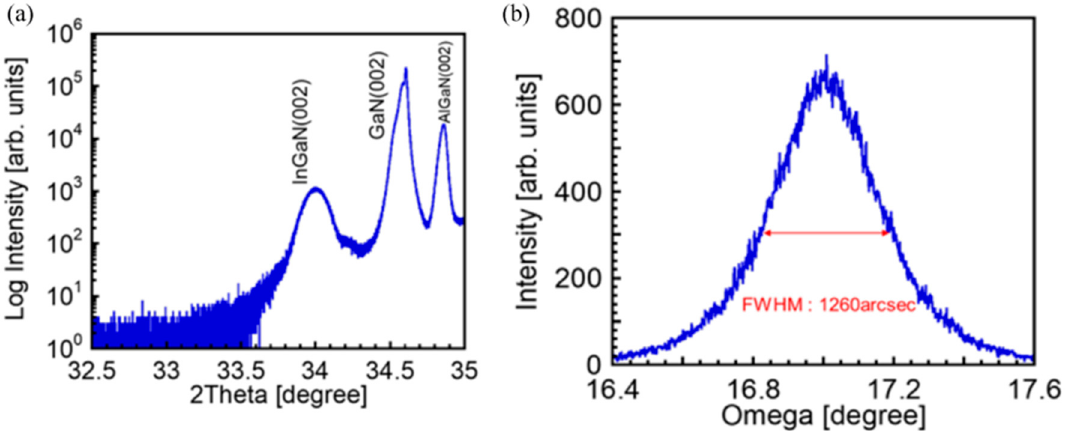
Figure 3. XRD reciprocal space mapping of (104)-plane for InGaN/GaN heterostructures at the temperature of 760 °C both on the ( a ) AlGaN/GaN-on-Si HEMT and ( b ) GaN/sapphire template.